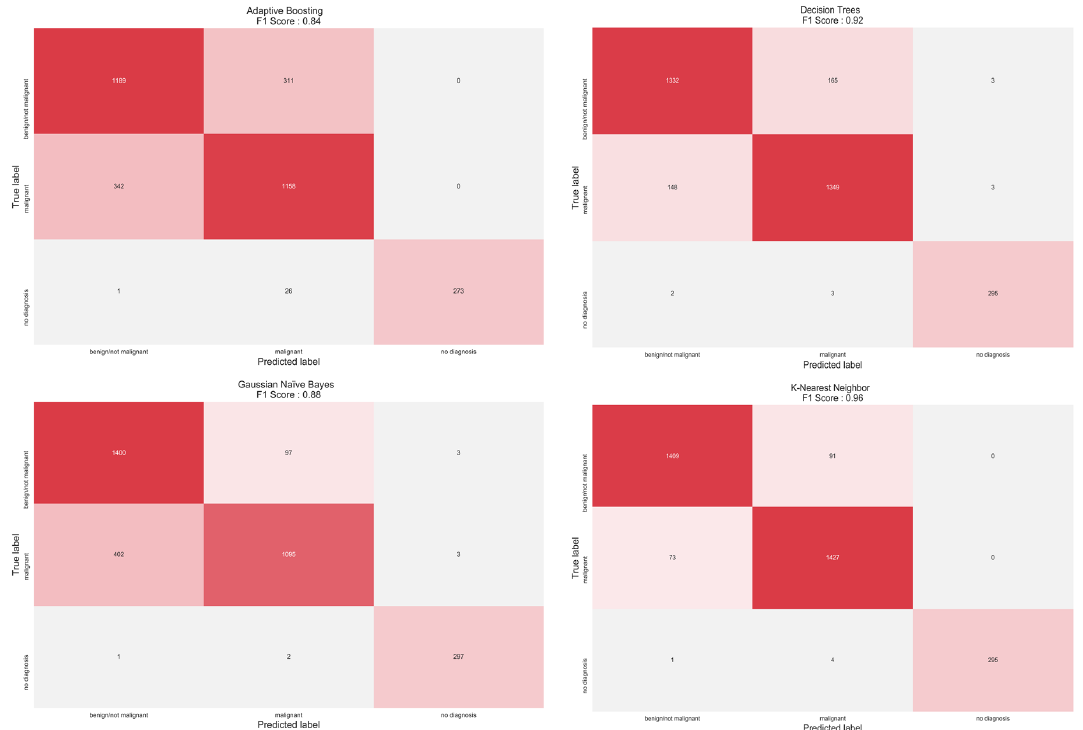
Figure 4. Performance evaluation using the confusion matrix of AB, DT, GNB, and KNN.